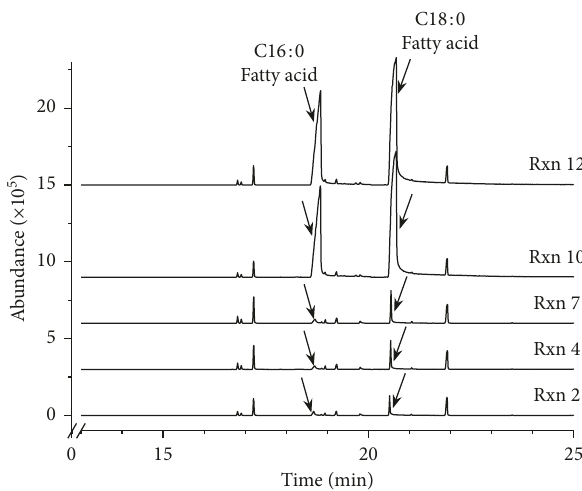
Figure 4: Results of Py-GC-MS analysis directly on methyl-es- terified products (FAMEs) showing the free C16:0 and C18 :0 fatty acids in Reaction 10 and Reaction 12. Extractable ion chromato- gram was obtained using m/z 256 for C16:0 fatty acid in the range of retention time 10 ∼ 20 min and m/z 284 for C18 :0 fatty acid in the range of retention time 20 ∼ 25